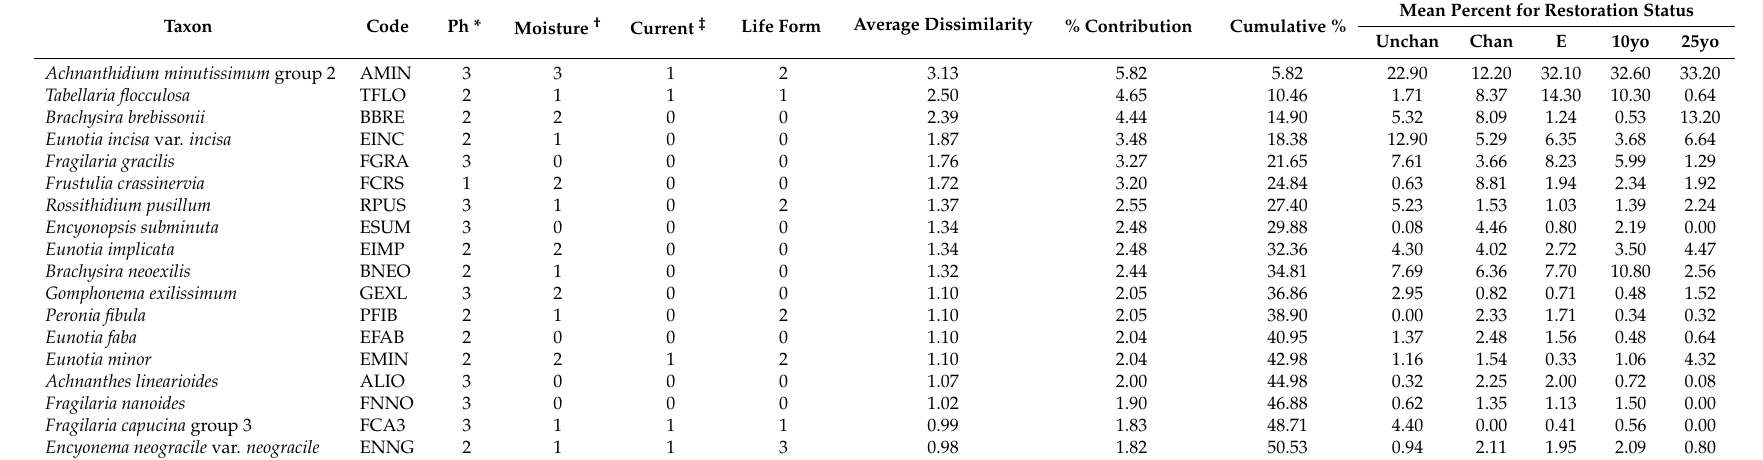
Table A5. SIMPER analysis of diatom taxa primarily responsible for the differences among streams that were unchannelized reference (Unchan), channelized